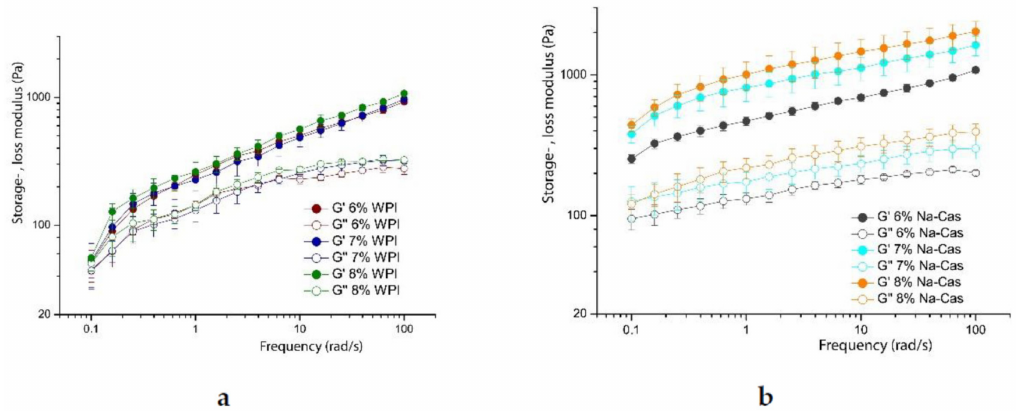
Figure 13. The storage ( G ’) and loss ( G’ ’) modulus in freuqency sweeps of WPI ( a ) and Na-Cas ( b ) in the concentration range from 6 to 8%, each, with 73% oil in water at shear deformations γ =